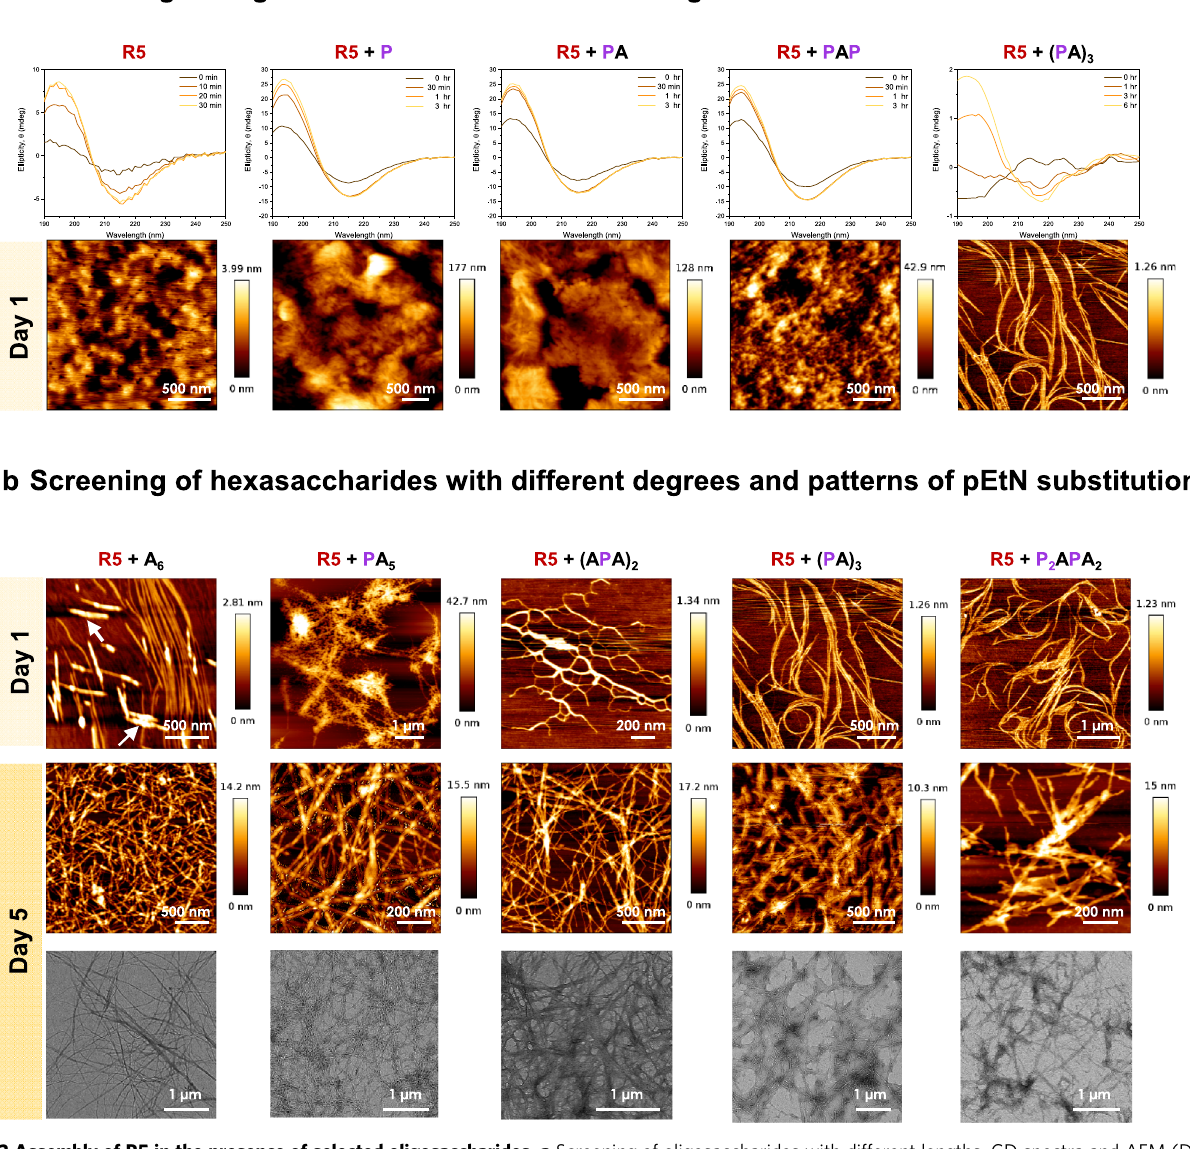
Fig. 2 Assembly of R5 in the presence of selected oligosaccharides. a Screening of oligosaccharides with different lengths. CD spectra and AFM (Day 1) of the samples containing R5 alone or in the presence of different oligosaccharides. The R5 alone sample results in ill-de fi ned aggregation, whereas fi ber- like structures of different dimensions are generated when R5 is assembled in the presence of an oligosaccharide. b Screening of hexasaccharides with different degrees and patterns of pEtN substitution. AFM (Day 1 and Day 5) and TEM (Day 5) of the samples containing R5 in the presence of hexasaccharides with different degrees and patterns of pEtN substitution. The aggregation of A 6 is indicated with white